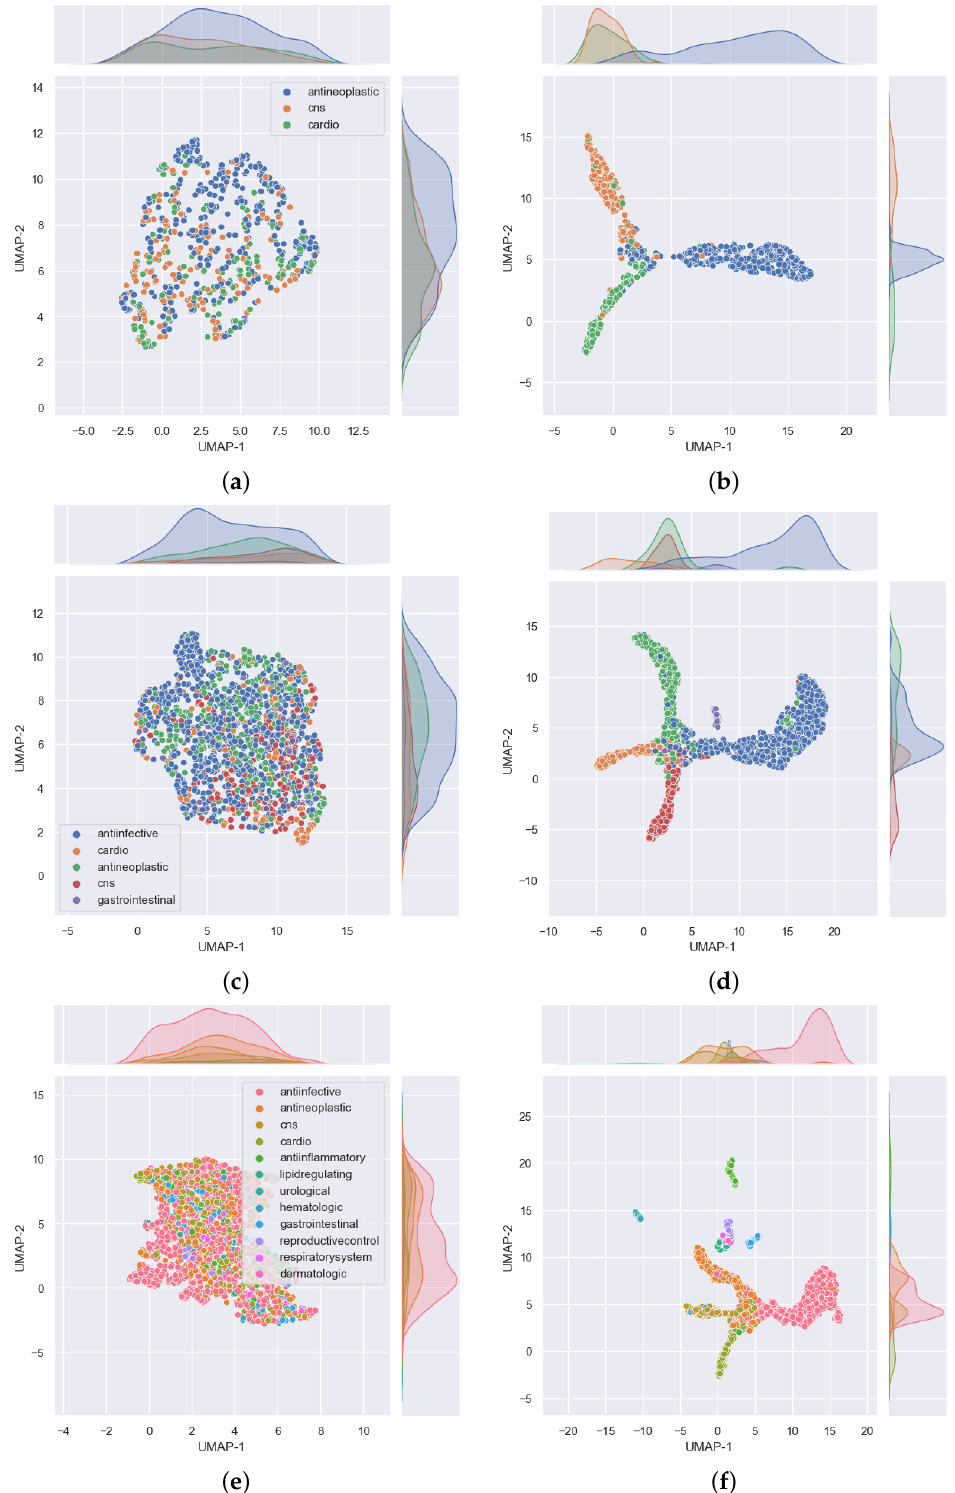
Figure 6. Distribution of the test data used in the 3, 5, and 12 single label classification task subgroups shown on ( a , c , e ), respectively. On the other hand, ( b , d , f ) show the distribution of the same data after passing it through our trained GCN models for 3-, 5-, and 12-task subgroups, respectively. The latter group of subfigures show that drugs belonging to one MeSH class appear closer to each other in the 2D UMAP space (which is not the case in the earlier group of subfigures). This shows that the models are able to classify the drugs into the 3, 5, and 12 MeSH classes as intended. These subfigures were plotted using Seaborn [26] after we reduced the dimensions of the drugs to two using UMAP